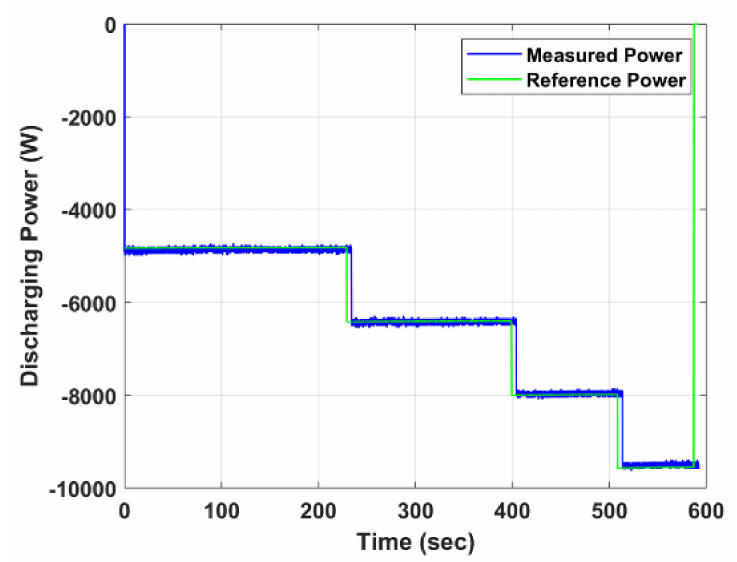
Figure 13. Measurement of DC power discharging from the battery.